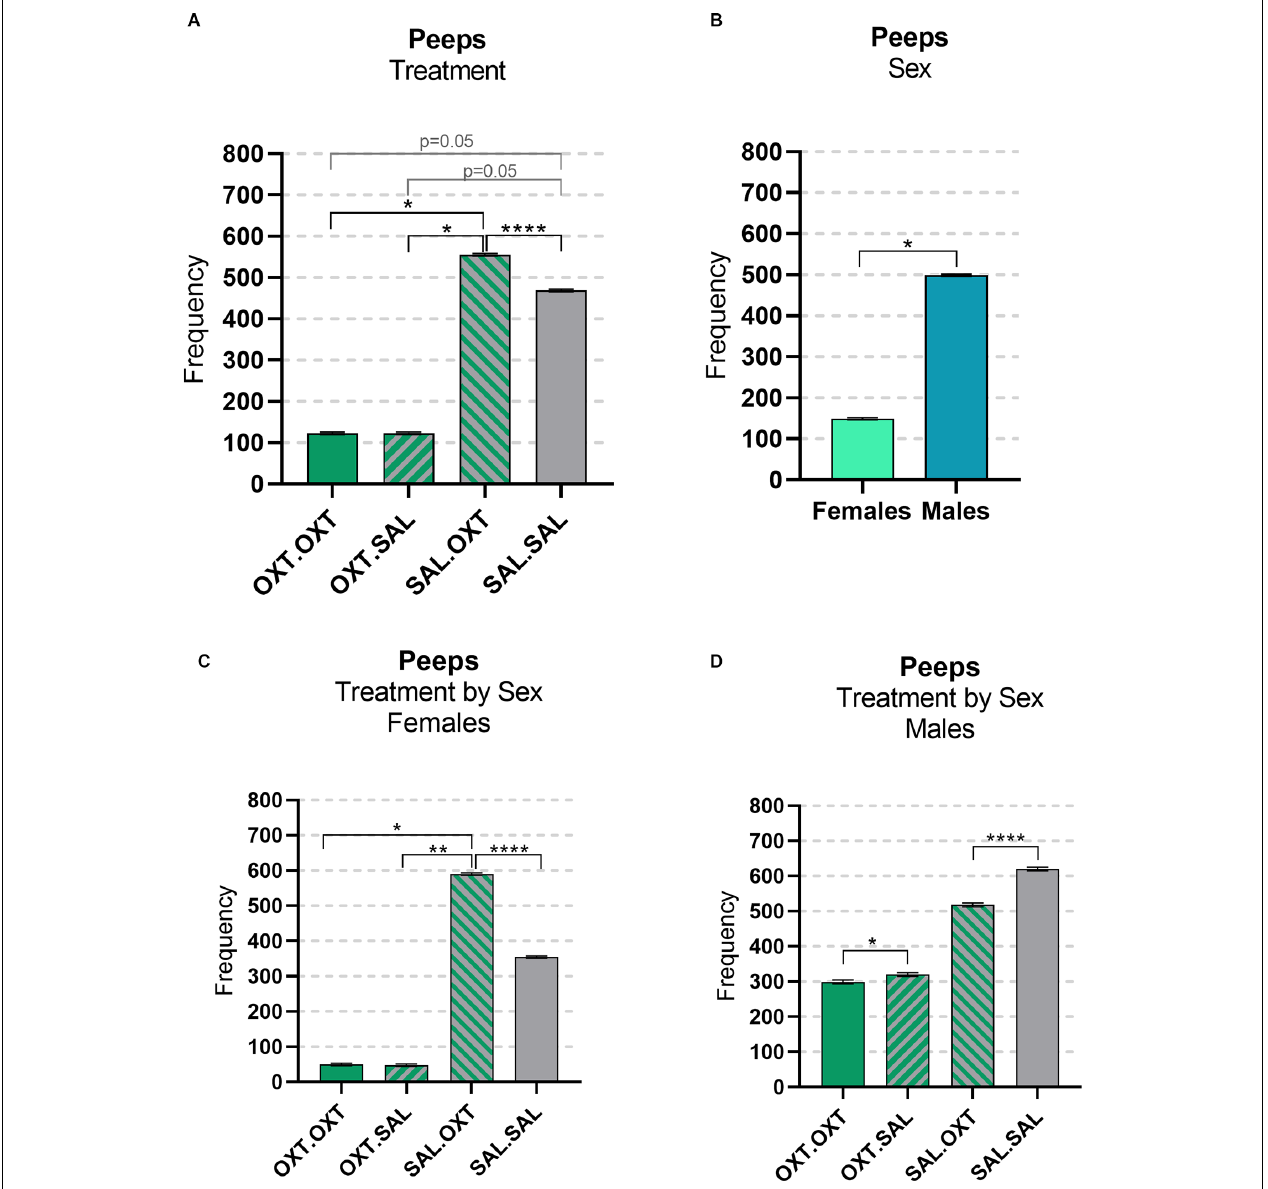
FIGURE 2 | Vocalizations: peeps. (A) OXT.OXT and OXT.SAL treated subjects vocalized less peeps than SAL.OXT subjects, SAL OXT subjects vocalized the most compared to other groups. (B) Females treated with OXT.OXT and OXT.SAL females vocalized less peeps than SAL. OXT females, SAL OXT females vocalized the most compared to all female groups. (C) Females treated with OXT.OXT or OXT.SAL had fewer peeps than females treated with SAL.OXT. Overall, SAL.OXT females vocalized the most peeps. (D) OXT.OXT males vocalized fewer peeps than OXT.SAL males. SAL.OXT males vocalized fewer peeps than SAL.SAL